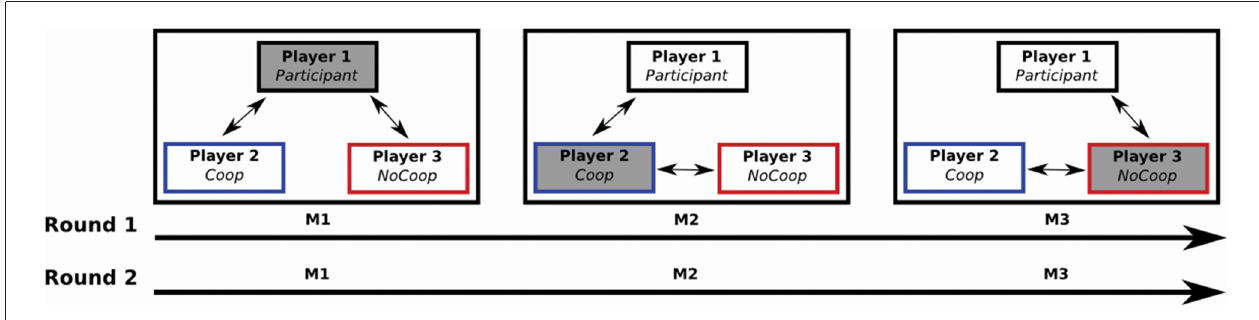
FIGURE 1 | A sequential iterated Dictator game: one participant and two confederates played two rounds of the game (M1, M2 and M3). Each M was composed of five iterations. Players received their payments after each iteration. The role of dictator alternated among the three players (filled gray box): in M1, the Participant (player 1) was the dictator (i.e., the player who decided to give or take money from the other two players after their payment); during M2 and M3, players 2 and 3 were the dictators respectively. Players 2 and 3 (confederates) were instructed for perform a specific strategy: player 2 performed a cooperative strategy (Coop), and player 3 a non-cooperative strategy